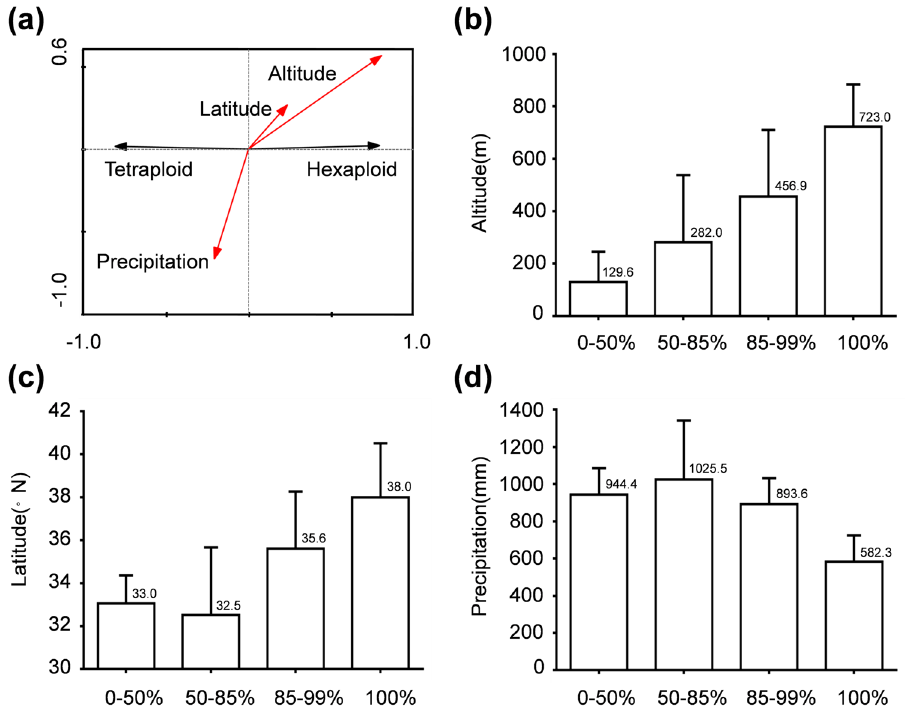
Figure 2. ( a ) The redundancy analysis on association between geographic/climatic variables and differential distribution pattern of hexaploids and tetraploids. Hexaploid and tetraploid are shown by black arrows, while altitude, latitude, and precipitation are shown by red arrows. Diagrams between different hexaploid frequencies and the correlated geographic/climatic variables including altitude ( b ), latitude ( c ) and precipitation ( d ). The X-axes indicate the hexaploid frequencies, and Y-axes indicate values of the correlated geographic/climatic